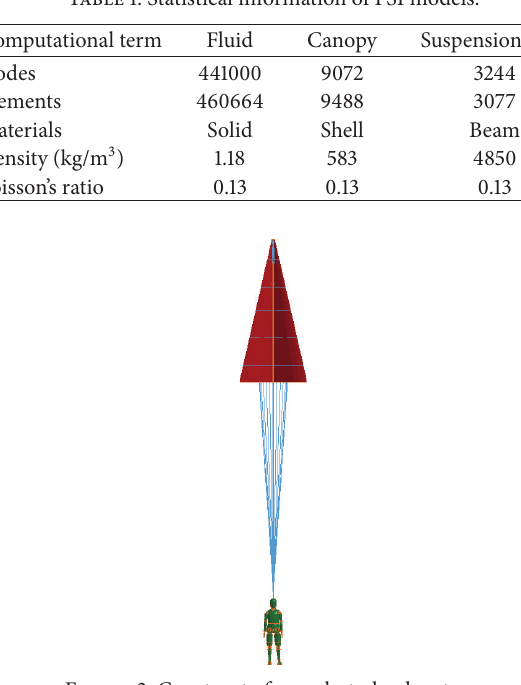
Figure 2: Construct of parachute-load system.